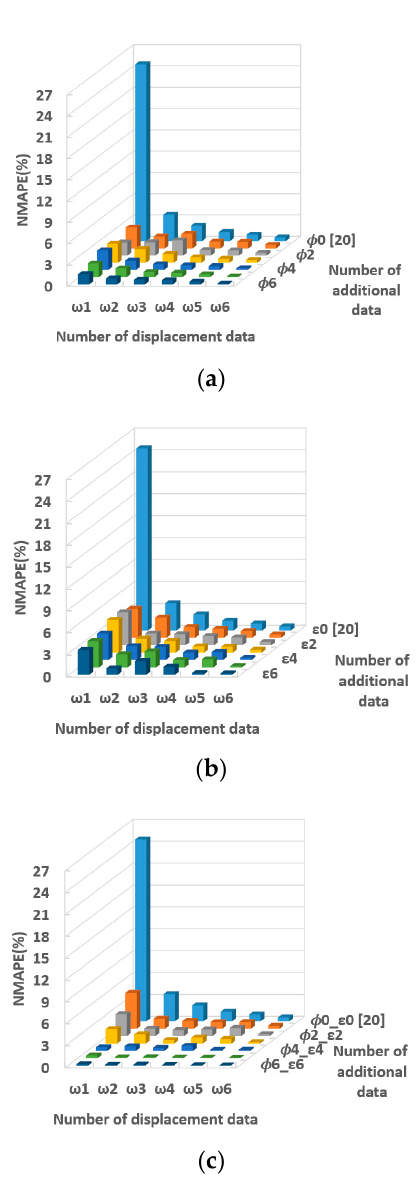
Figure 22. NMAPE according to the number and combination of sensors (RDS3): ( a ) displacement + slope, ( b ) displacement + strain, ( c ) displacement + slope + strain.